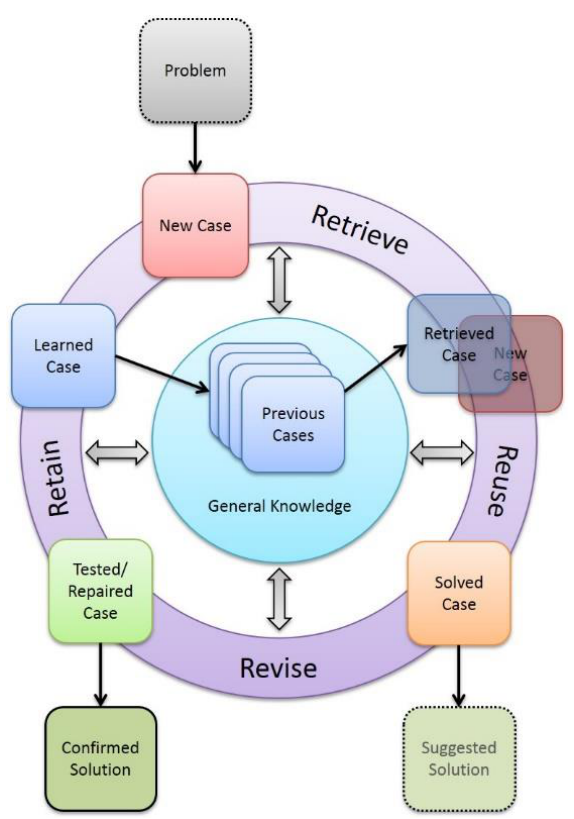
Figure 1. The case-based reasoning cycle, redrawn after [16].